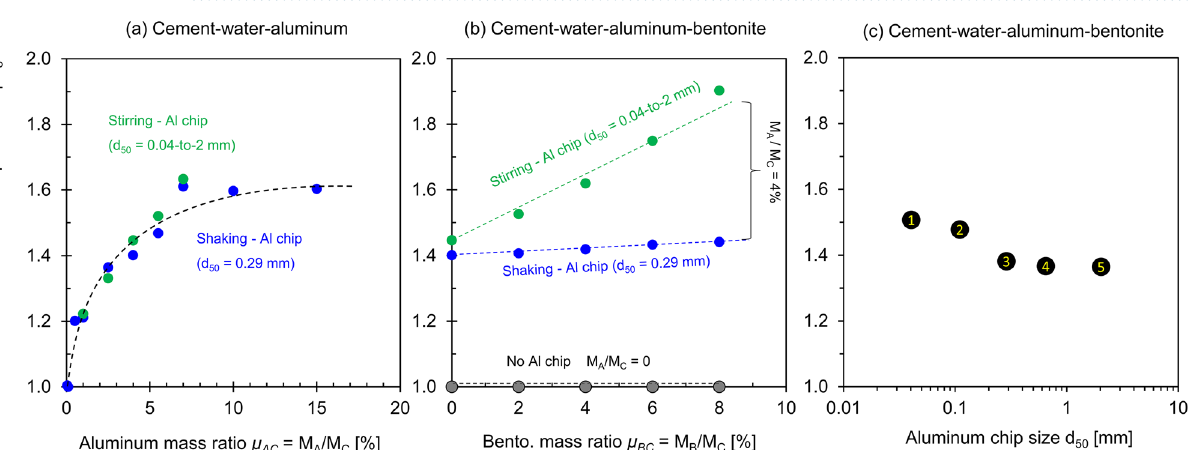
Figure 2. Normalized volume expansion versus elapsed time. ( a ) Cement–water–aluminum mixtures for different aluminum mass ratios prepared with a chip size of d 50 = 0.29 mm. ( b ) Cement–water–aluminium– bentonite mixtures for five different bentonite mass ratios at an aluminum mass ratio μ AC = M A /M C = 4%. ( c ) Cement–water–aluminium–bentonite mixtures for five different aluminum chip size d 50 prepared with an aluminum mass ratio μ AC = M A /M C = 4%, bentonite mass ratio μ BC = M B /M C = 8%. Note : All mixtures: water- cement ratio μ WC = M W /M C = 100%.